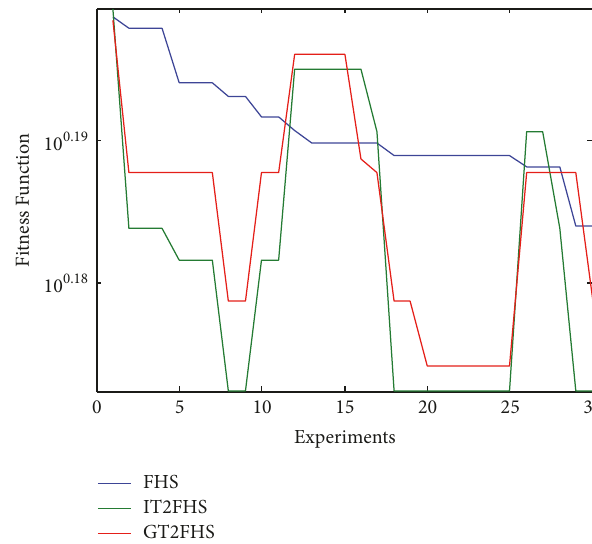
Figure 11: Representation of results for each method without perturbations. Figure 12: Representation of results for each method with pertur-